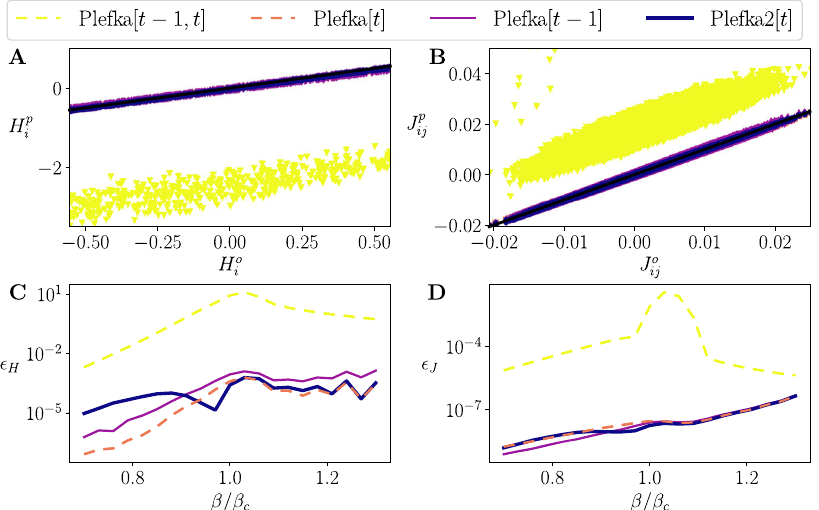
Fig. 4 Inverse Ising problem. Top: Inferred external fi elds ( A ) and couplings ( B ) found by different mean- fi eld models plotted versus the real ones for β = β c . Black lines represent the identity line. Bottom: Average squared error of inferred external fi elds ϵ ( D ) for 21 values of β in the range [0.7 β c , 1.3 β c parameters rescaled by a new inverse temperature the correlations (Fig. 5D, E) show that in this case Plefka[ t − 1, t ] works badly, not being able to capture the transition. Plefka[ t − 1] shows similar performances as in the forward problem, and Plefka [ t ] and Plefka2[ t ] have a similar behavior, underestimating